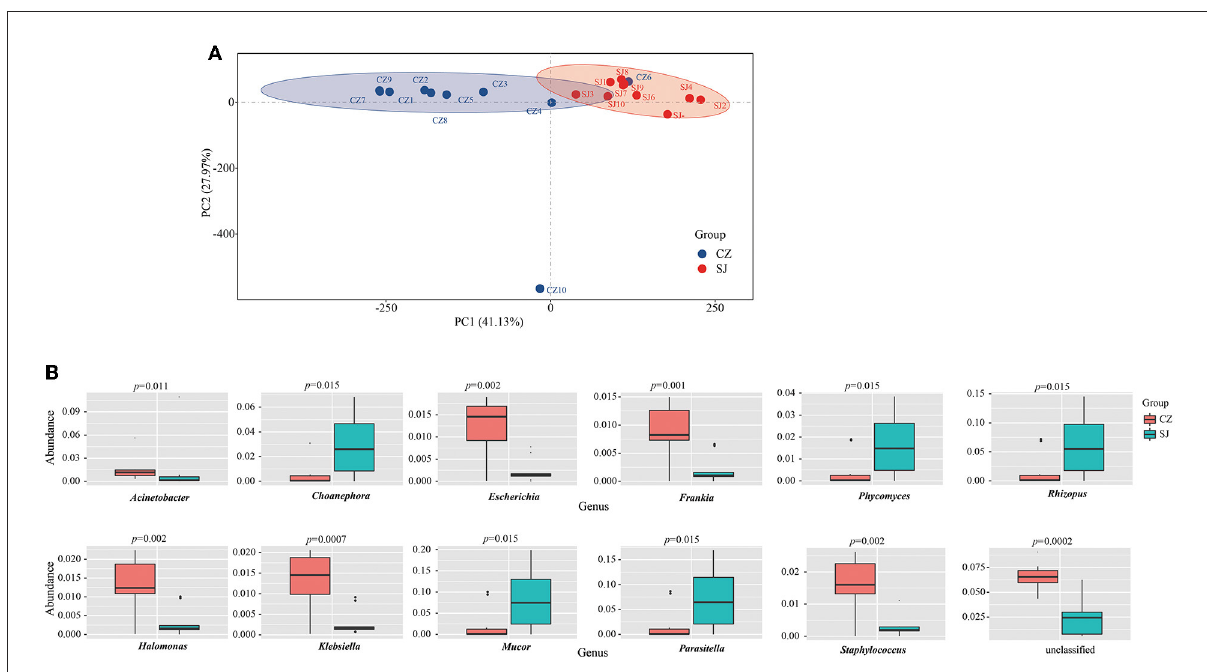
FIGURE2 Principal component analysis (PCA) (A) and different genera (B) of the gut microbes of Anser erythropus sampled from Shengjin (SJ) and Caizi (CZ)